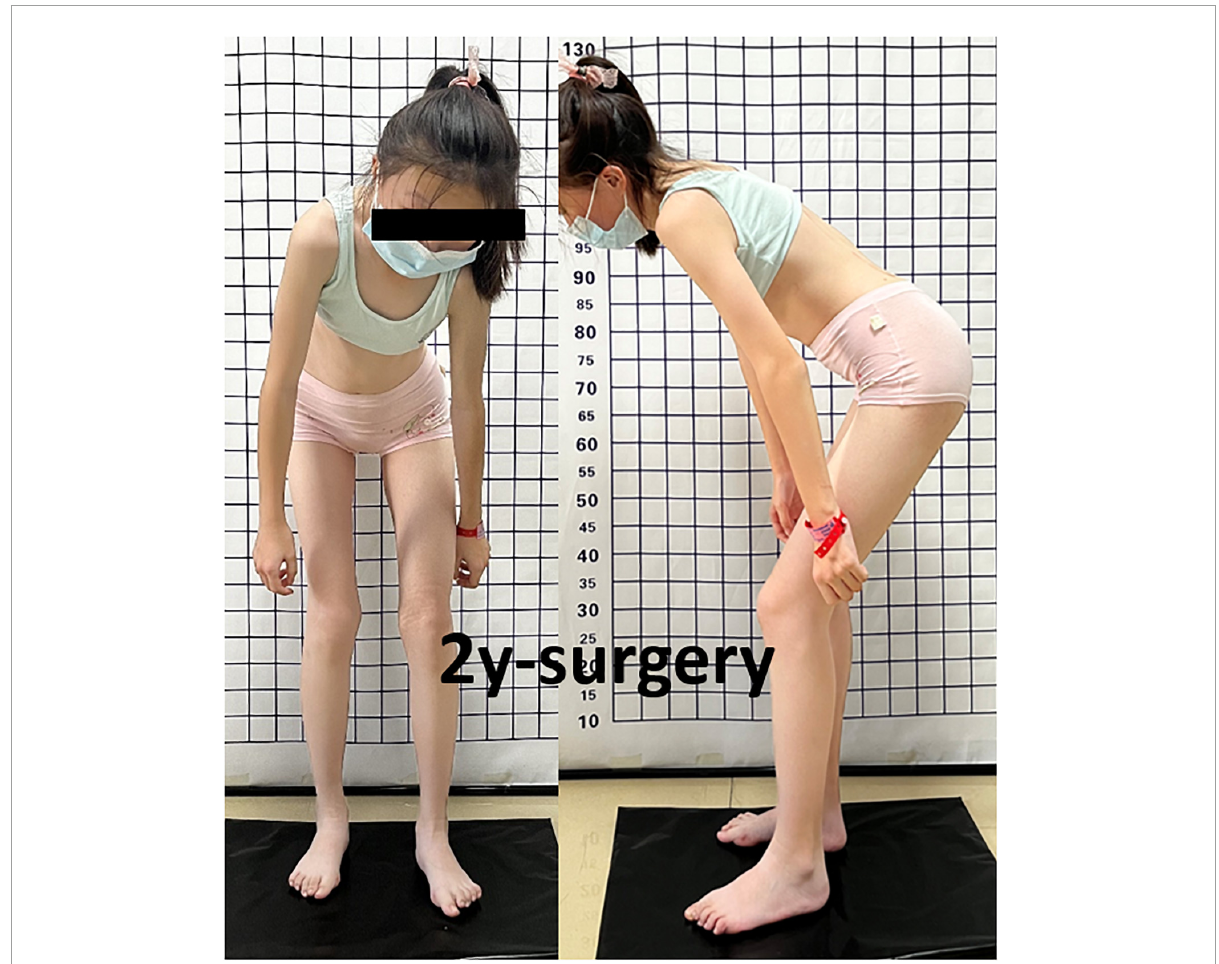
FIGURE6 Passive left hip ROM was restricted to 80 ◦ of flexion, 5 ◦ of external rotation, and 15 ◦ of abduction with no abnormal gait pattern.